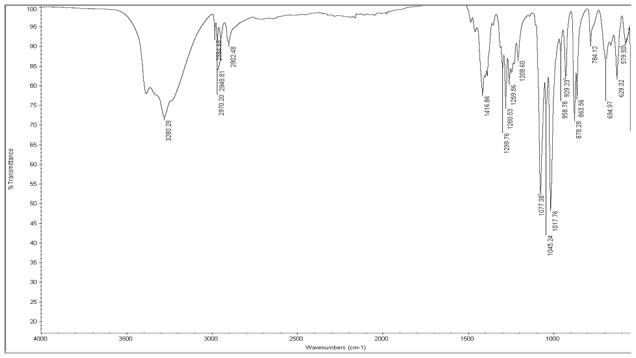
FTIR spectrum of D-mannitol.The bands 1209, 1077, 1018, 959 and 929−1 were assigned for mod I polymorph of the excipient.